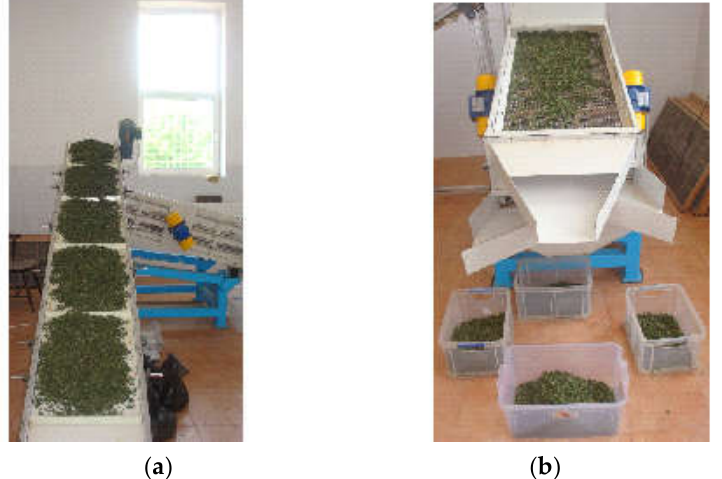
Figure 3. Industrial-type sieve sorter developed at INMA Bucharest. ( a ) Plant conveyor; ( b ) Plant sorter.